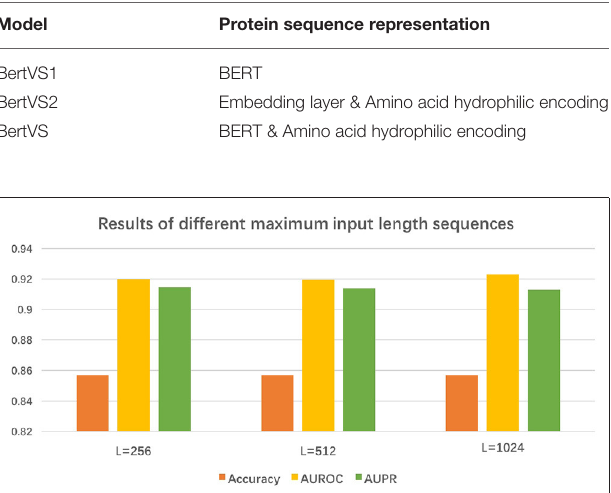
TABLE 4 | The detailed description of the variants of our model.